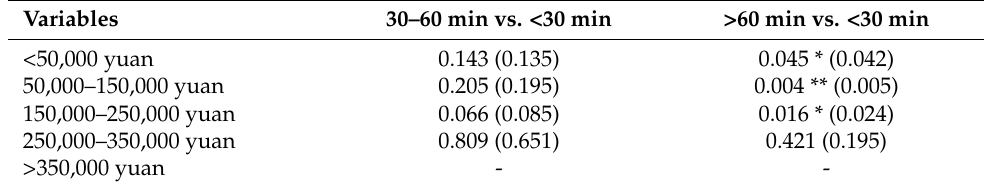
Table 3. Time spent in UGSs during the lockdown explained by yearly household income.